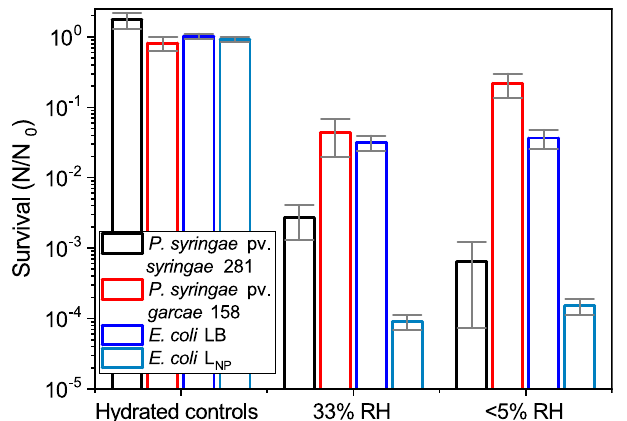
Figure 7. Desiccation tolerance at different relative humidity (RH) values. Survival of hydrated controls and samples desiccated at 33% and < 5% RH for 6 days at 20 °C of P. syringae pv. syringae 281, P. syringae pv. garcae 158, and E. coli grown either on LB or L NP are presented. The 281 strain is shown to be sensitive to dehydration, while 158 is considerably more tolerant to this treatment. E. coli tolerated relatively well the desiccation, but when grown in L NP minimal medium these cells were inactivated by additional 3 logs. Error bars denote standard deviations of the means (n =